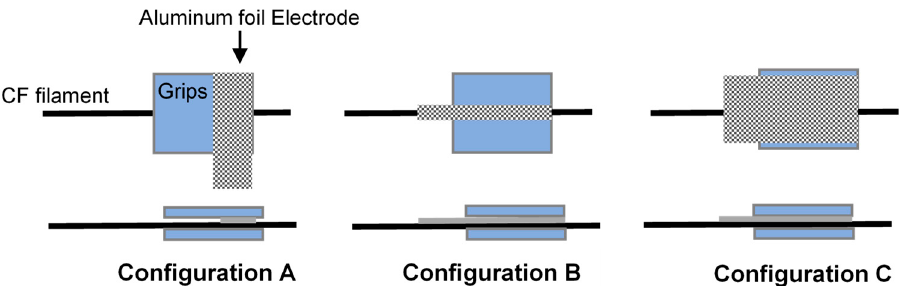
Figure 3. Port Figure 3. Port configurations.